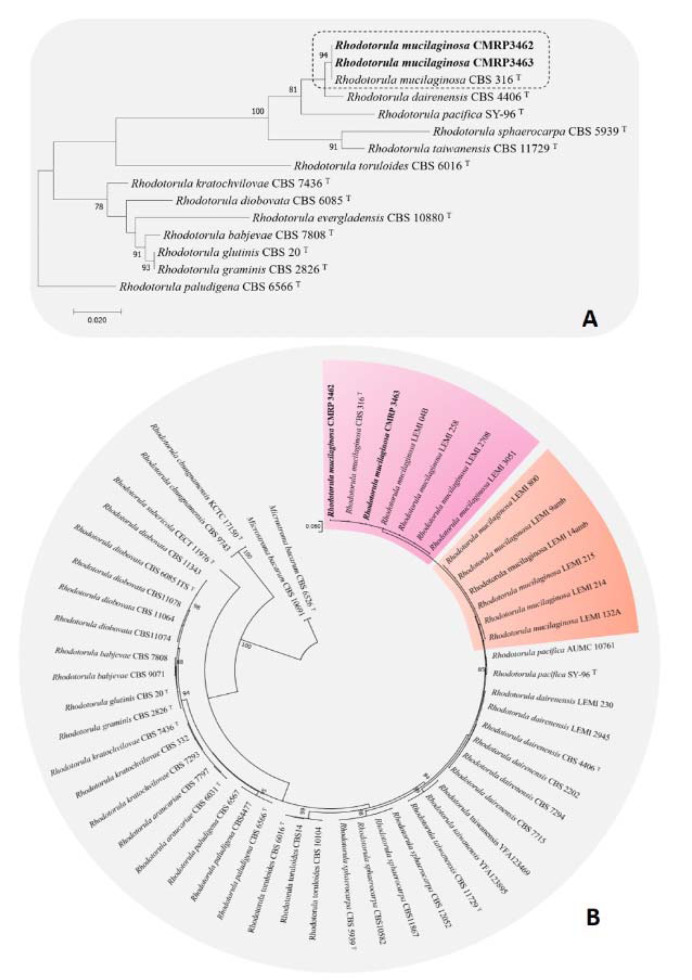
Phylogenetic analysis of Rhodotorula mucilaginosa, based on ITS sequences constructed with Maximum likelihood, based on the Tamura-Nei model + Gamma distribution (T92+G) implemented in MEGA v.7. Bootstrap support was calculated from 1000 replicates. (T) = type strain of the species. Bootstrap values > 80 % were considered statistically significant. (A) Phylogenetic tree of Rhodosporidium clade, Sporidiobolaceae family. Rhodotorula paludigena CBS6566T was taken as outgroup. (B) Phylogenetic tree of R. mucilaginosa variability among clinical and environmental isolates of Nunes et al. (2013). (amb) = environmental lineages. Microstroma bacarum CBS 6526T and CBS10691 were taken as outgroup.